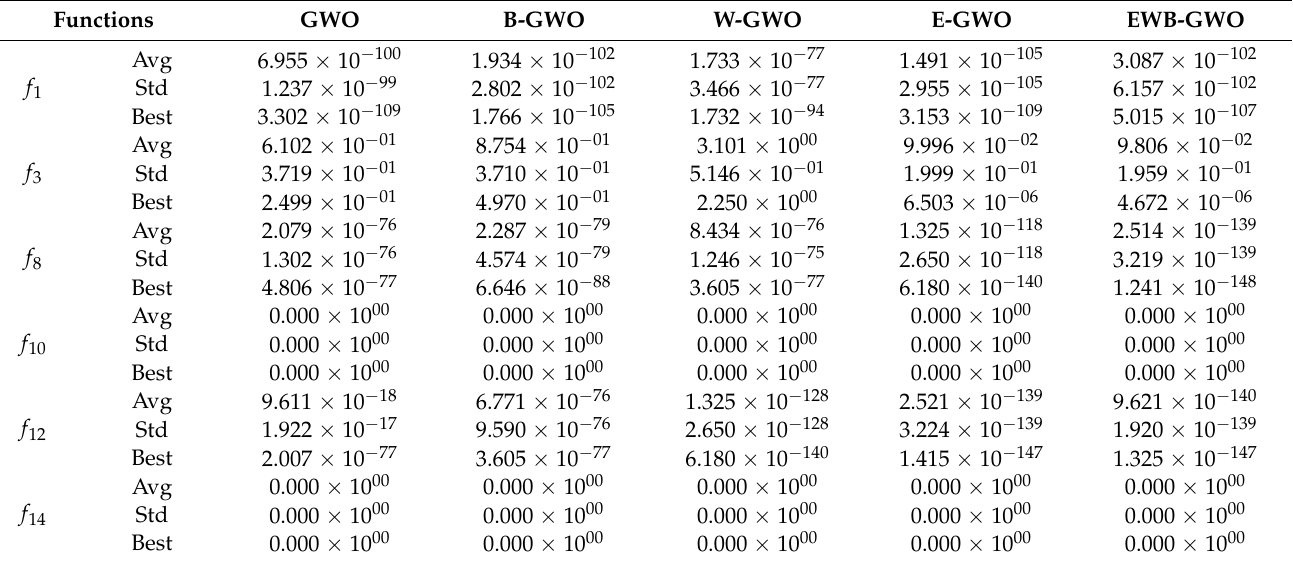
Figure 11. Comparison of convergence curves of GWO, E − GWO, W − GWO, B − GWO, and EWB − GWO with Dim = 100. Table 2. Test results of the algorithm at Dim =